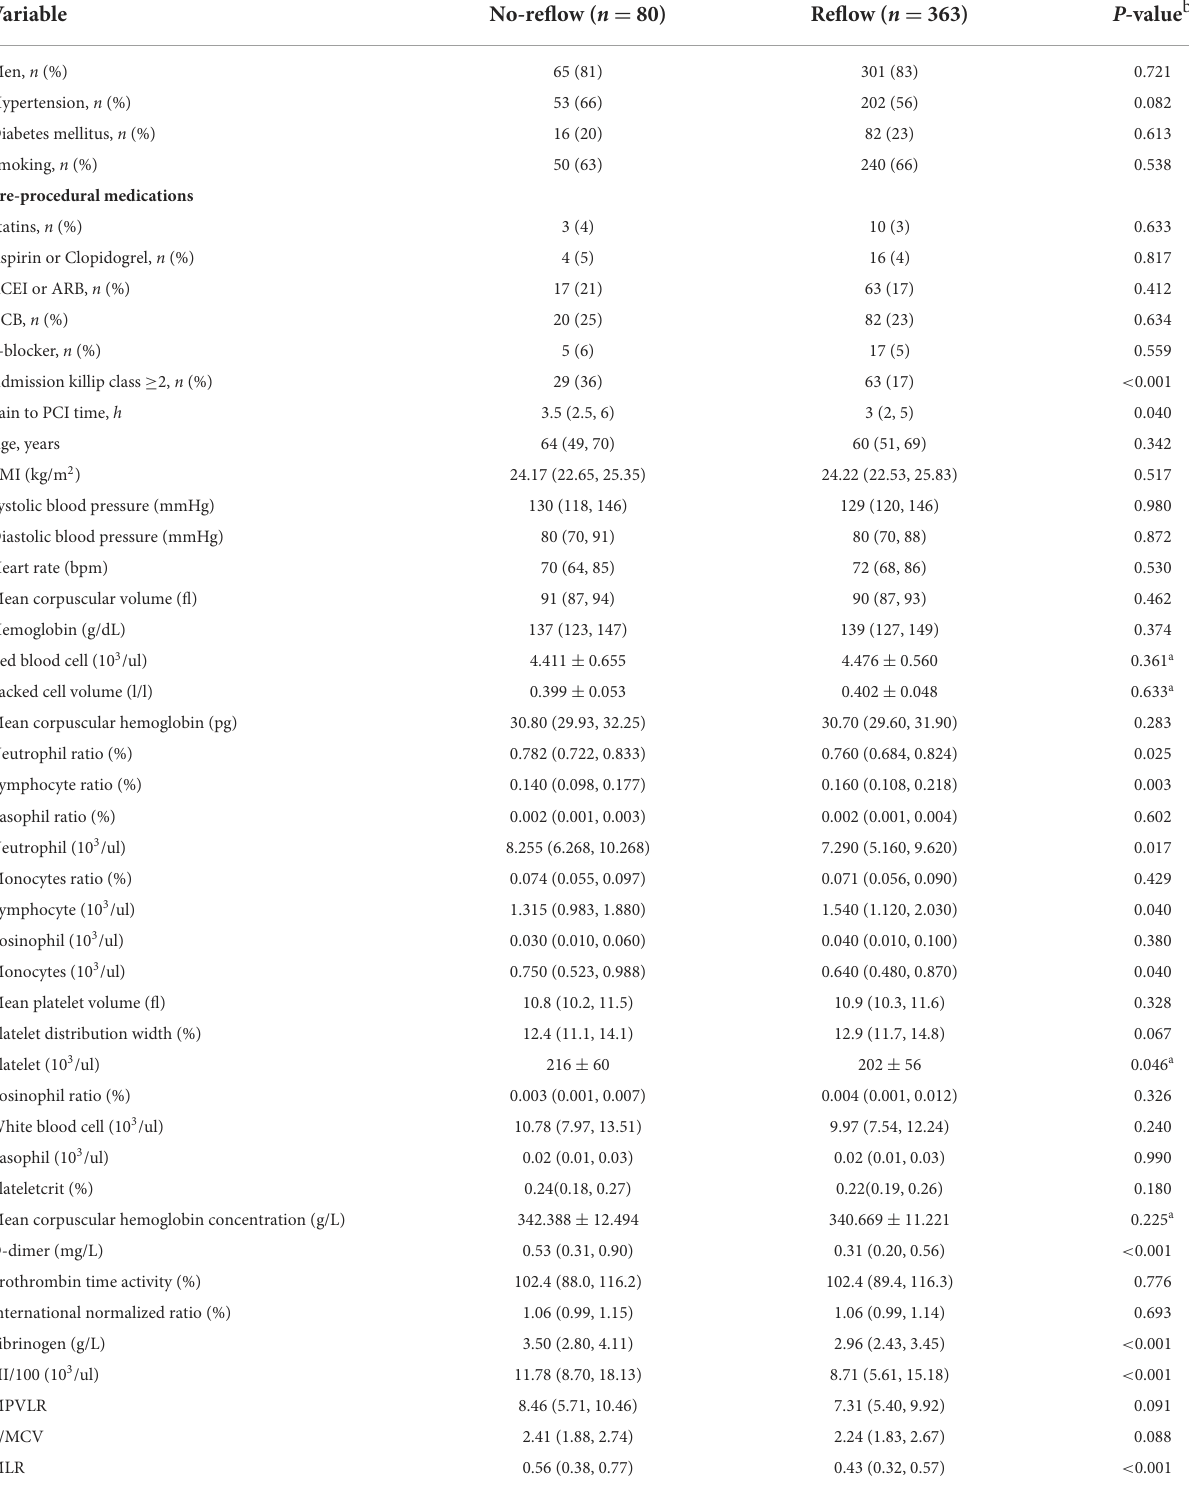
TABLE 1 Basic clinical characteristics of no-reflow group and reflow